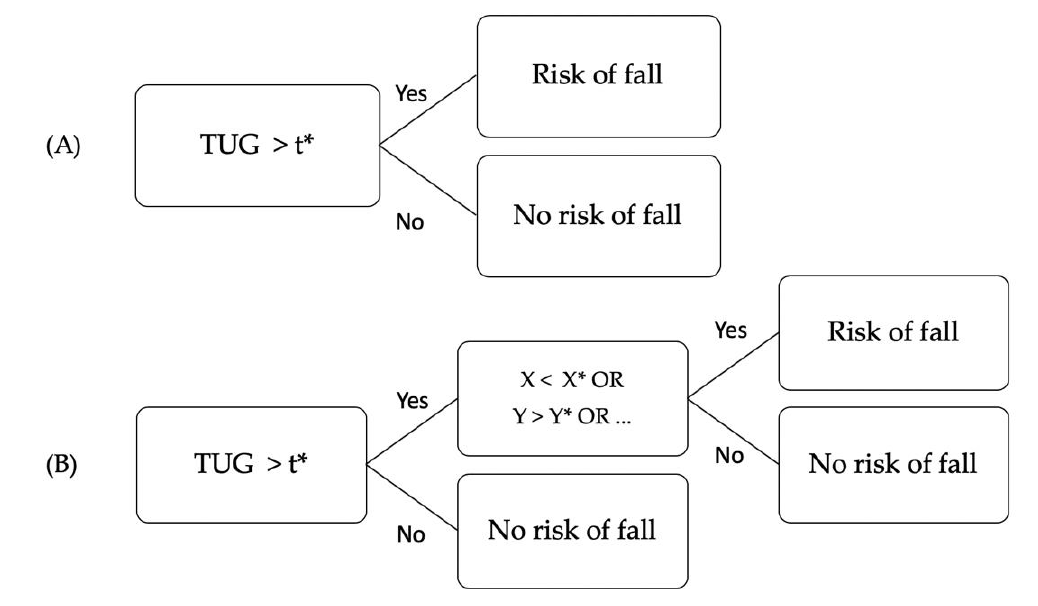
Figure 3. ( A ) Decision tree illustrating the TUG test. T* is the threshold time maximizing Youden’s index. ( B ) Decision tree illustrating the TUG+ test. X, Y, etc., are variability indices and X*, Y*, etc., are threshold values. The selected indices and thresholds are given in Figure 5B.